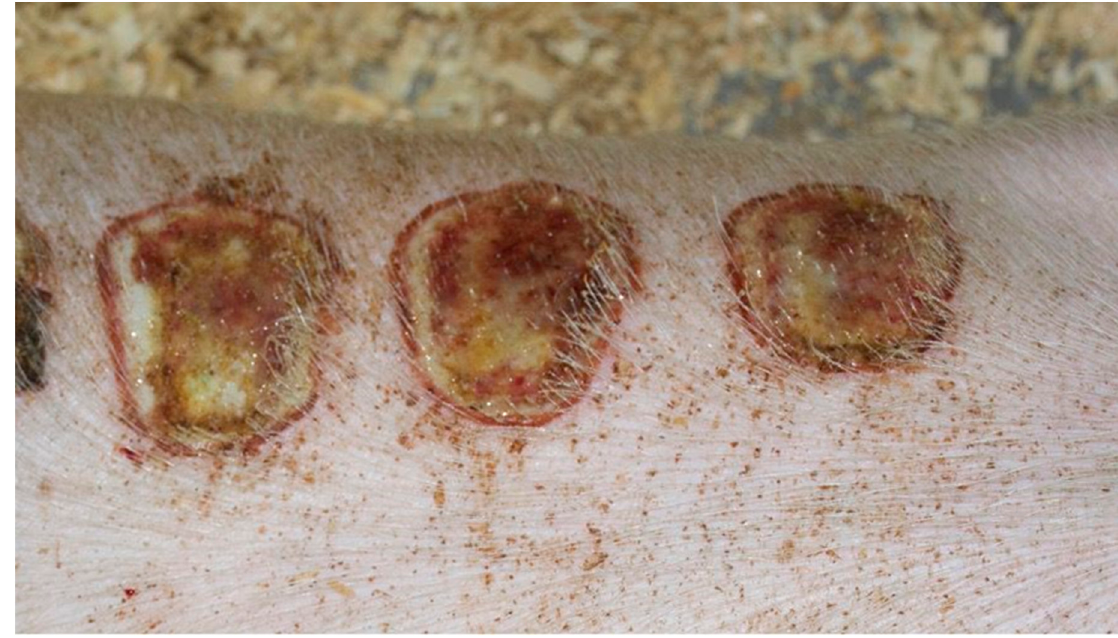
Figure 1. Group D1—burn wound treated with the 1% propolis ointment on day 5.